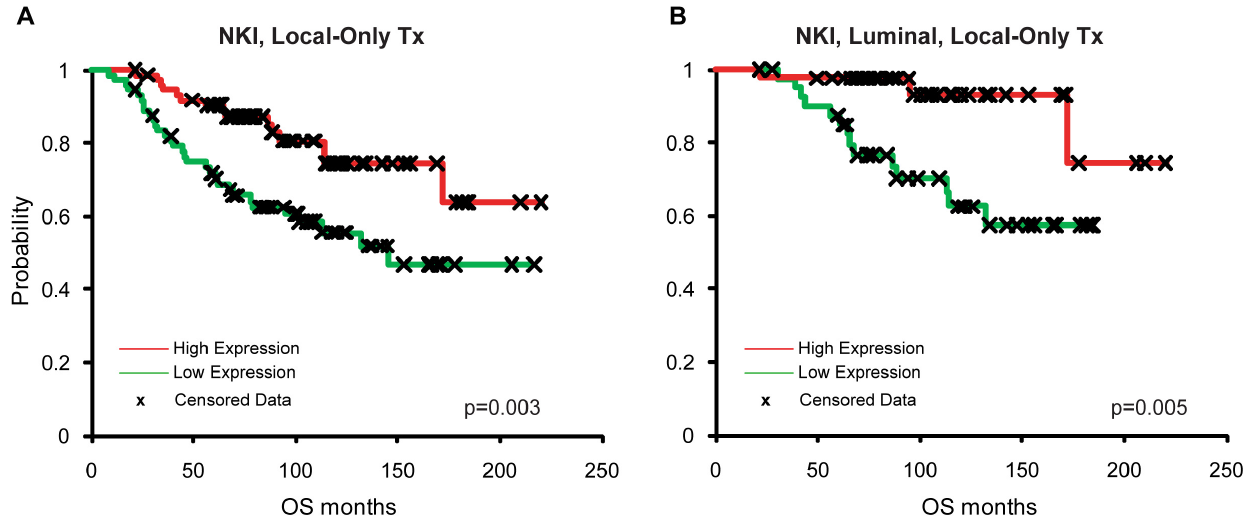
Figure 2. c-Myb high expression correlates with good prognosis across all breast cancer patients and within luminal tumors. Kaplan- Meier overall survival (OS) analysis based on c-Myb expression values rank ordered (high-to-low) and divided into halves. NKI-147 (A) All patients (n=147), (B) Luminal A and B subtypes only (n=84).